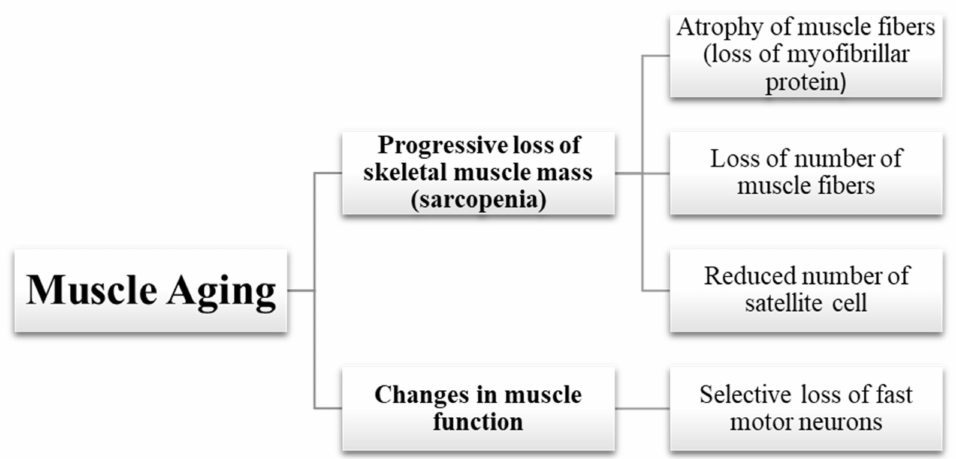
Figure 2. Summary of aging-related pathophysiological changes in